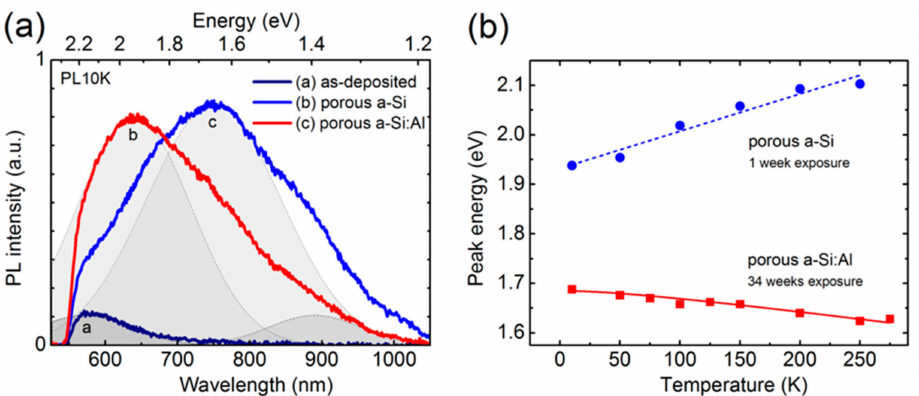
Figure 5. ( a ) PL spectra obtained at 10 K (488 nm excitation and low-pass LP550 filtering) of as-deposited a-Si:Al nanostructure, nanoporous a-Si (fully-etched Al NWs, one-week exposure to air), and porous a-Si:Al (partially-etched Al NWs, 34-week exposure to air). Gaussian curves indicate the main luminescence components. ( b ) PL peak energy as a function of temperature for nanoporous a-Si and porous a-Si:Al. The corresponding temperature coe ffi cients (dE / dT) are + 0.75 meV / K and − 0.32 meV / K,